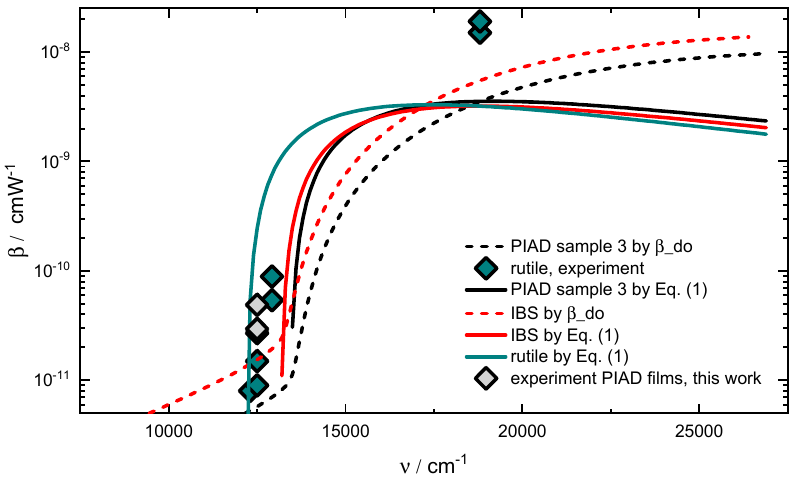
Figure 9. Measured TPA coefficients from rutile and PIAD TiO 2 compared to simulations in terms of Equations (1), (3), and (4).